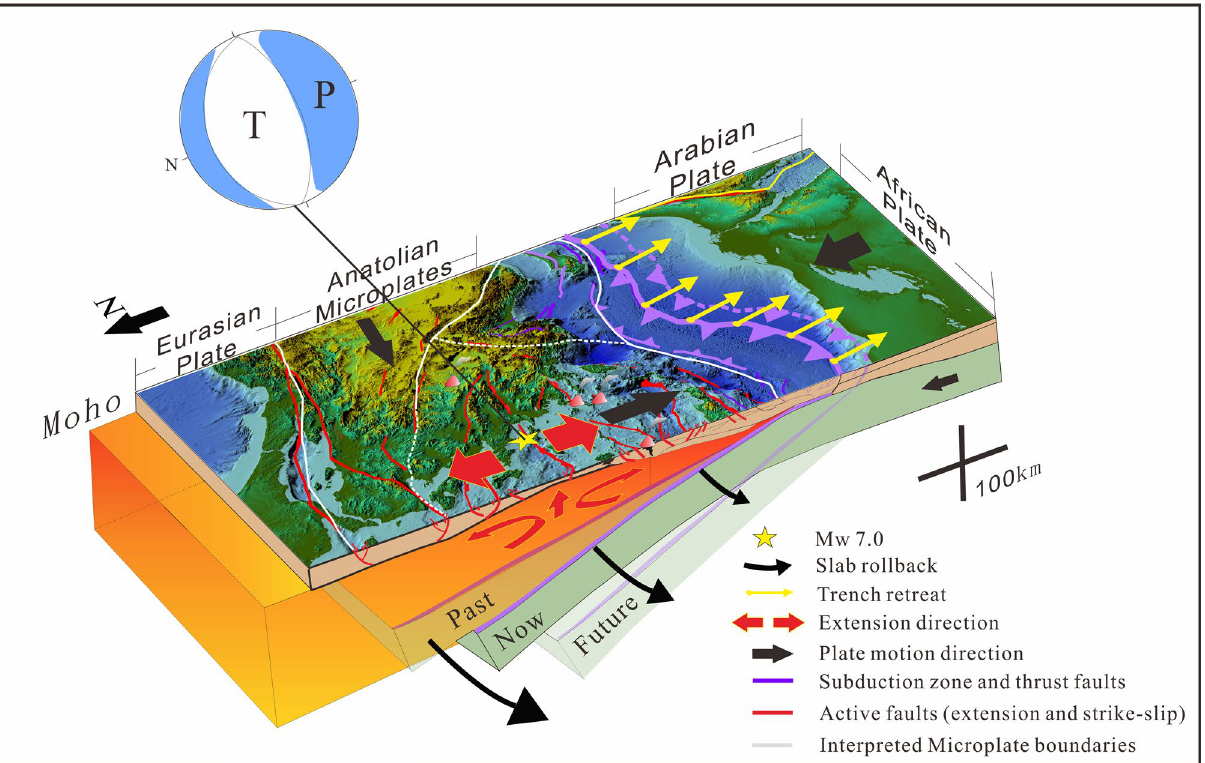
Figure 5. Tectonic model explaining the forces that triggered the Samos earthquake. The African plate is subducting to the north in the Hellenic and Cyprus trenches, the trench and upper plate are retreating as the slabs roll back to the south, exposed in the Cycladian Islands of the Aegean. The upper plate forearc is coupled to the rolling-back lower plate, which are retreating together, breaking the upper plate into numerous small microplates, forming the Aegean and Western Anatolian extensional provinces in the upper